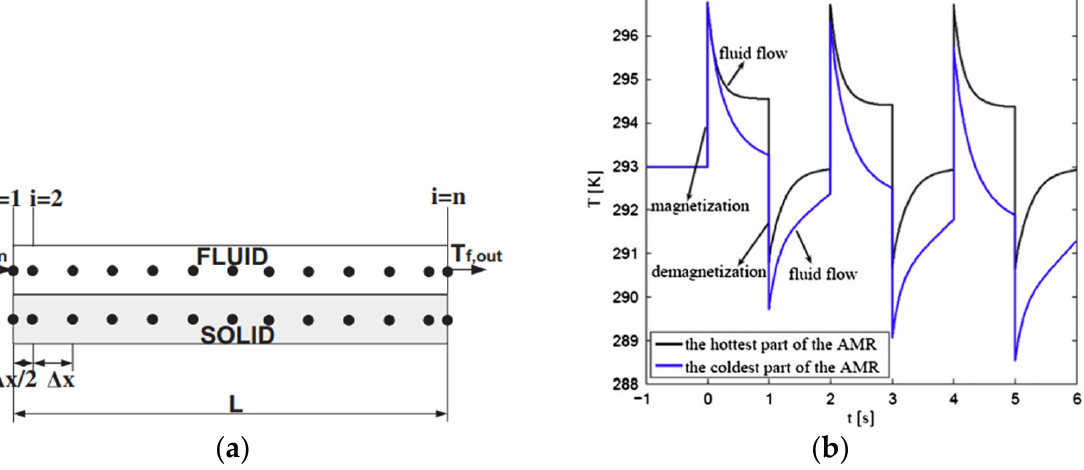
Figure 18. ( a ) Modeled geometry and ( b ) solution of the MCM temperature evolution [65].